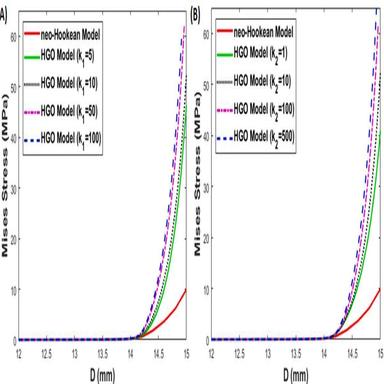
Influence of parameters (A) k1 (k2 = 10) and (B) k2 (k1 = 10 MPa) used in Tunica Albuginea (TA) on the response of penile tissue in IPP expansion simulation (α = 90◦ and d = 0).